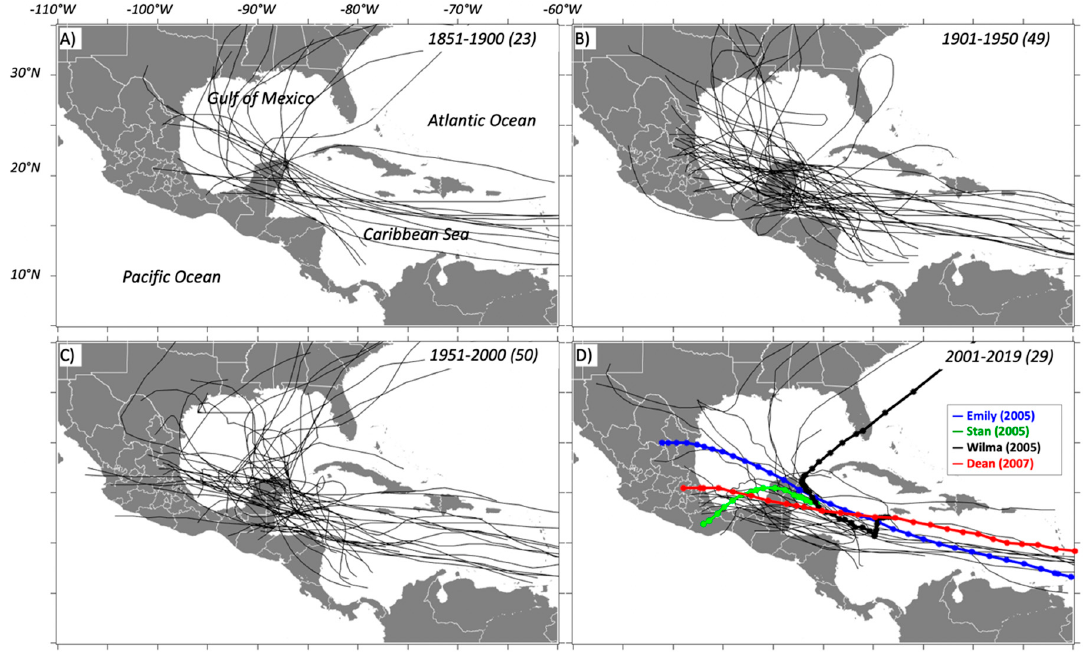
Figure 3. Tracks of 151 tropical cyclones (TCs) making landfall in the Yucatan Peninsula from 1851–2019; ( A – C ) covers 50 years each, and ( D ) covers the most recent 19 years (TCs totals for each period shown in parenthesis). Color lines represent the trajectories of four selected tropical cyclones in 2005 and 2007 discussed in the text (see methods).